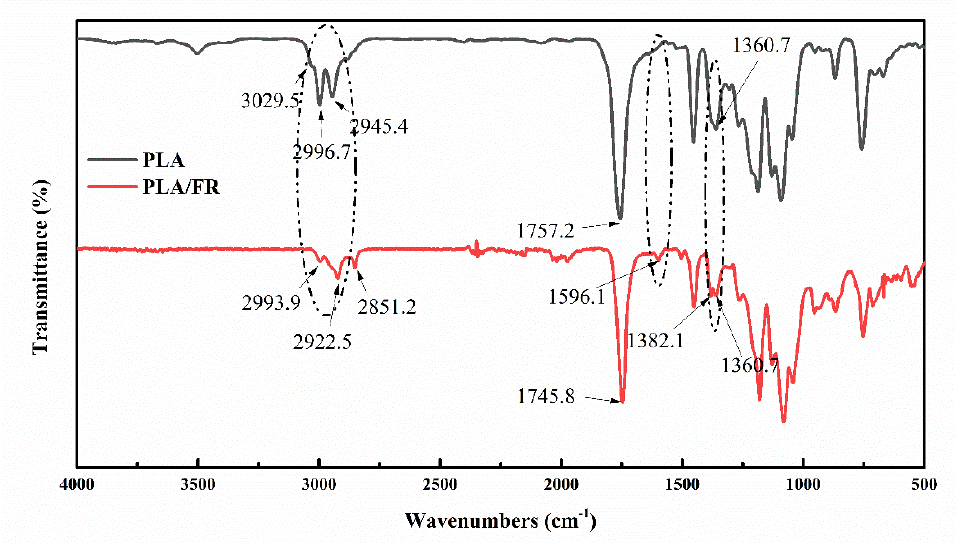
Figure 9. FTIR of neat PLA and its blend with 25 wt% HABP-DOPO.